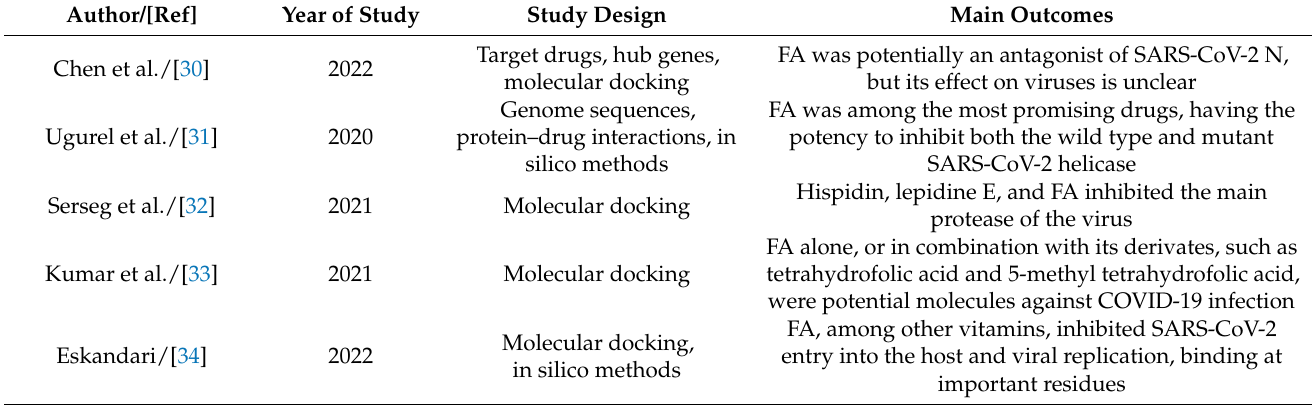
Table 1. Studies in silico and molecular docking concerning the potential association between folic acid and